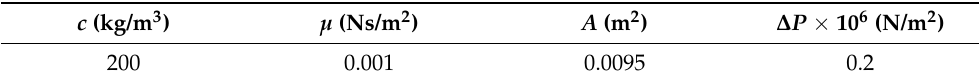
Table 2. The parameters used in Equation (2).